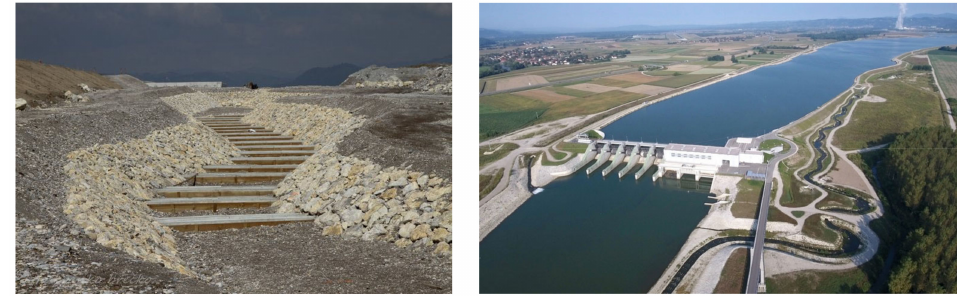
Figure 3. An exemplary fishway at HPP Brežice, Sava River.